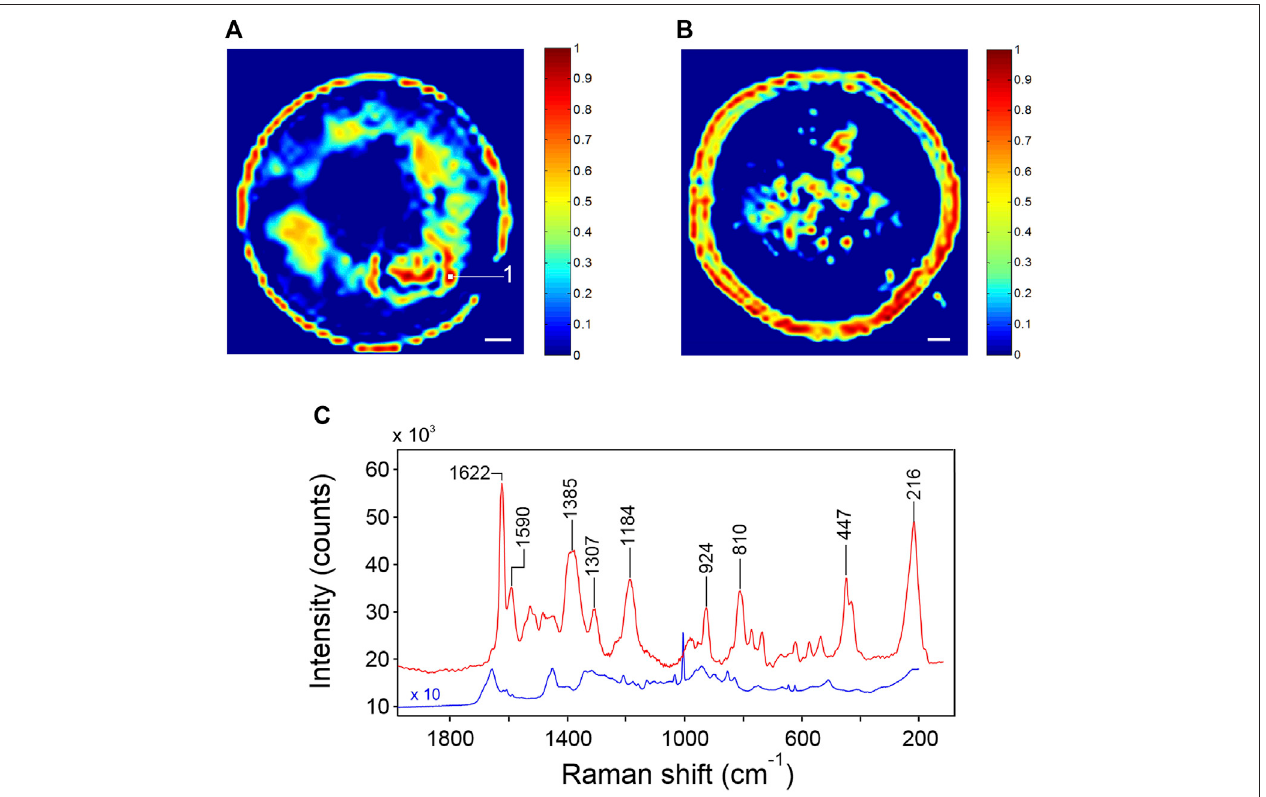
FIGURE 7 | (A,B) Raman images of two representative SERS spots functionalized with a 100- μ M solution of BSA. The image reconstruction was made by considering the intensity of the 216-cm − 1 peak. The scale bar is 20 μ m. (C) SERS spectrum of BSA collected in point one of Figure 7A (red trace); Raman spectrum of solid BSA (blue